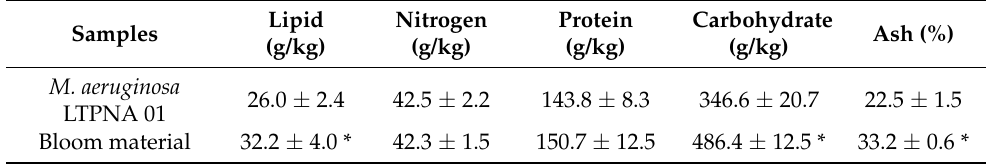
Table 1. Comparison of nutrients and ash of Microcystis aeruginosa LTPNA 01 and bloom material (g/kg of dry weight or %, n = 5, average ± coefficient of variation).